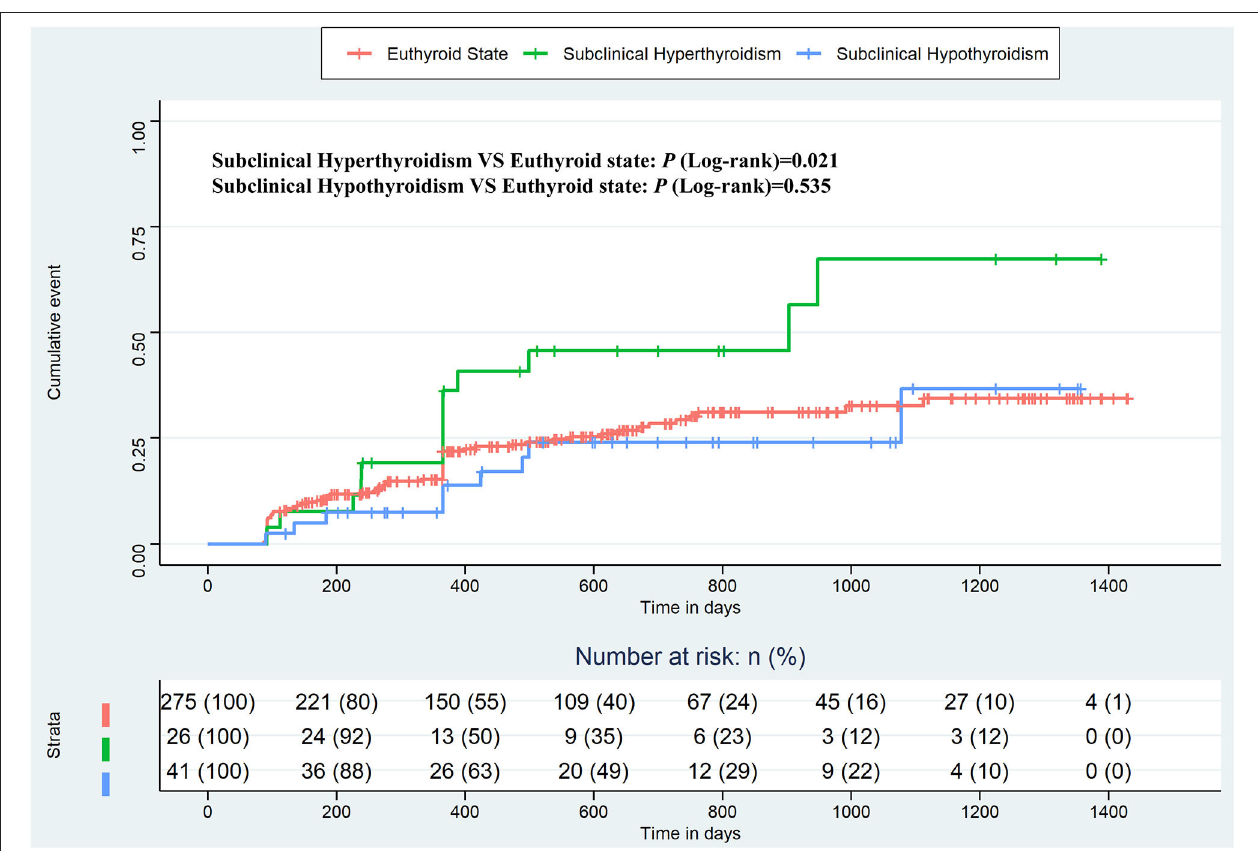
FIGURE 2 | Kaplan–Meier plot estimates of the rate of recurrence of atrial fibrillation according to thyroid function, considering the euthyroid state as a reference.